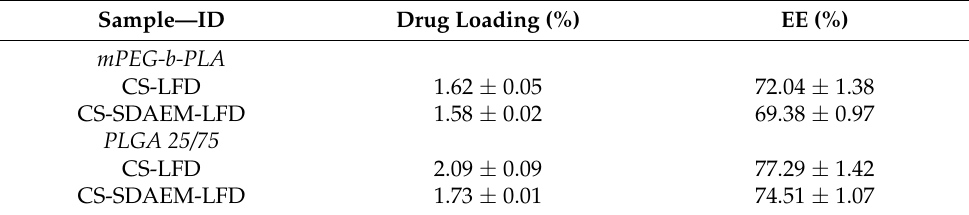
Table 3. Drug loading and EE for the prepared LFD-loaded thin-films.